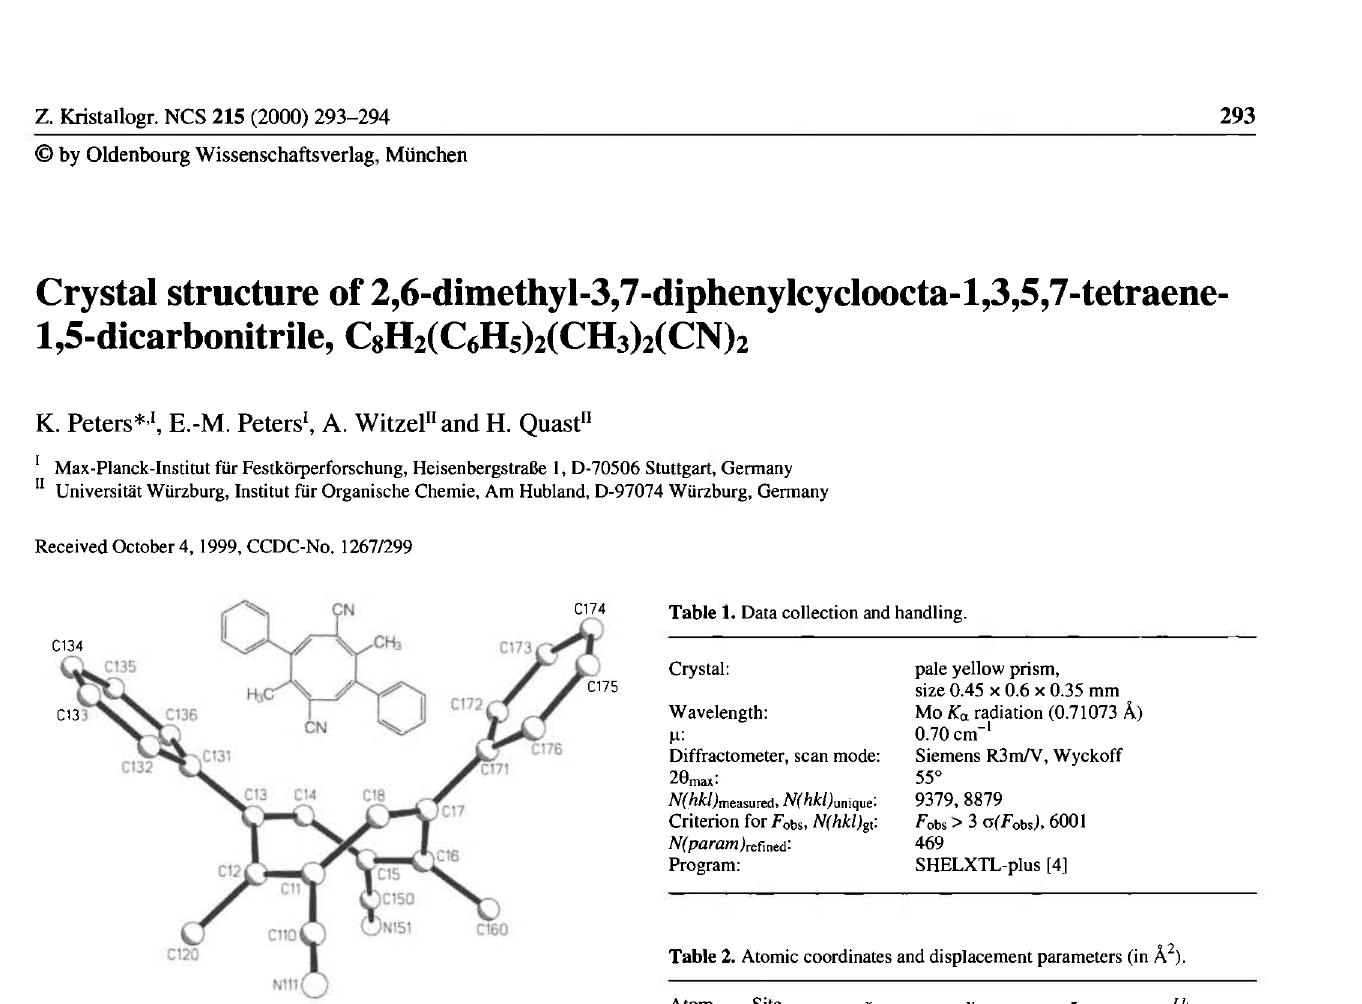
Table 2. Atomic coordinates and displacement parameters (in Ä 2